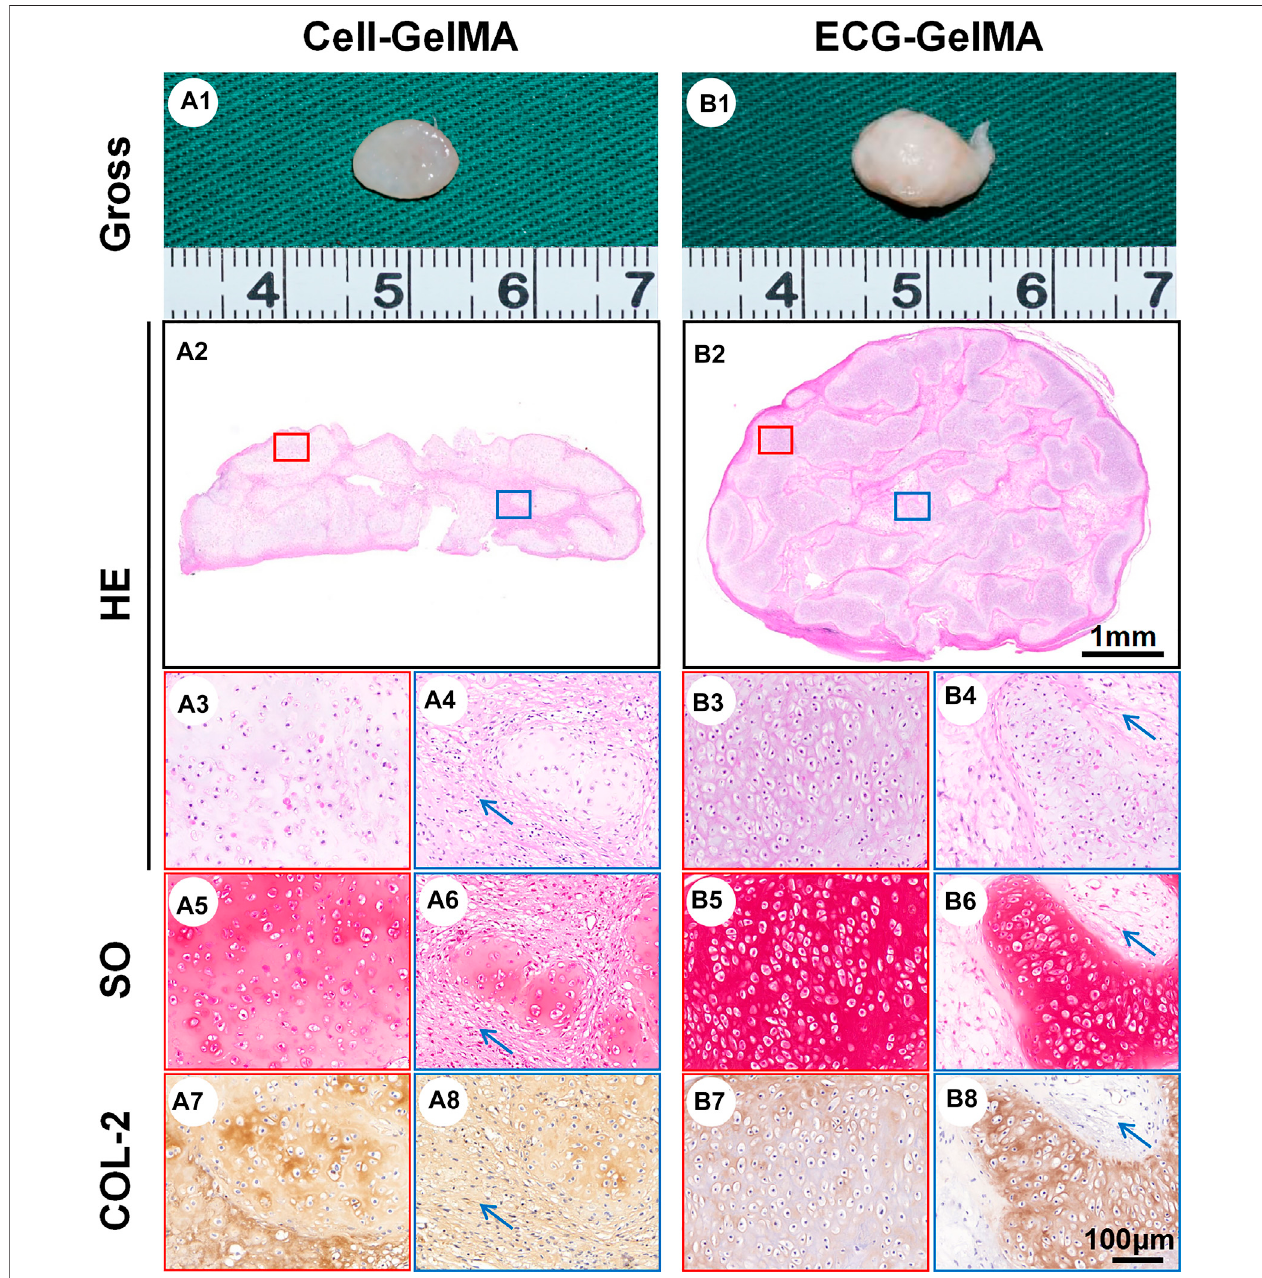
FIGURE 4 | Gross view and histological examination of regenerated cartilage in Cell-GelMA and ECG-GelMA after 8 weeks implantation in nude mice. Gross view (A1andB1),HE(A2-A4andB2-B4),SO(A5-A6andB5-B6),andimmunohistochemicalCOL-2(A7-A8andB7-B8)staininginCell-GelMAandECG-GelMAgroups.The blue box represents magni fi ed images at inner zone of regenerated cartilage, and the red box represents magni fi ed images at peripheral zone of regenerated cartilage. The blue arrows indicate fi brous tissue.